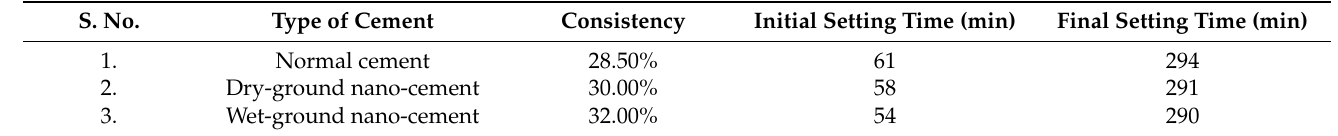
Table 1. Properties of cements.